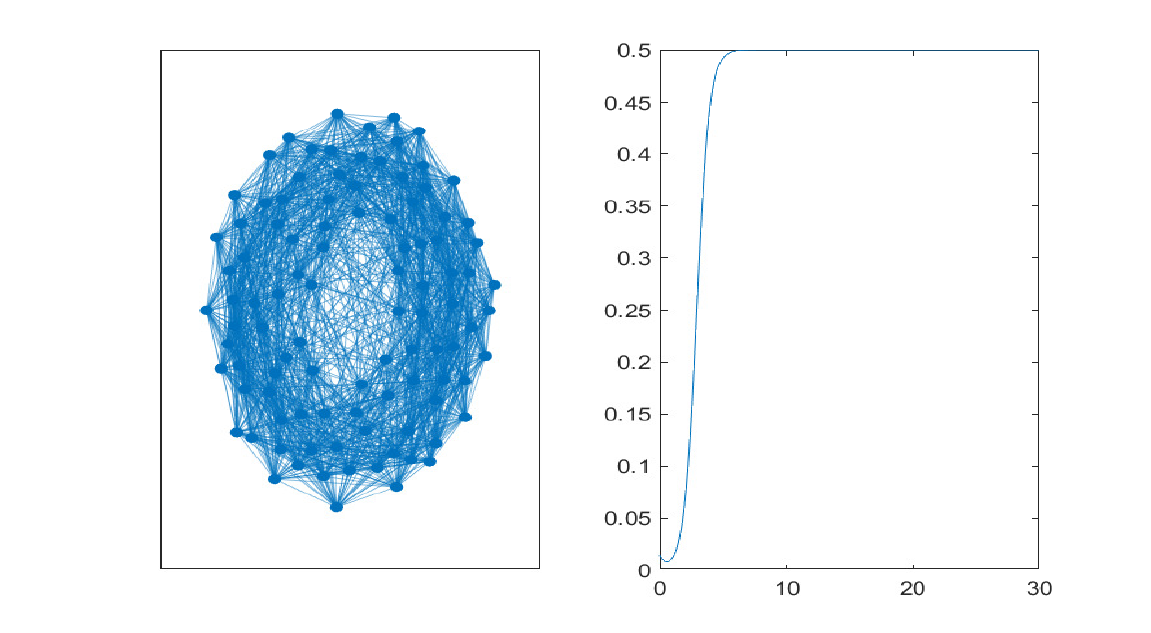
Figure 9. Small-world (Watts-Strogatz) network with 100 nodes and a rewiring probability of β = 0.1 ( left ). Time evolution of the mean value of non-performing loans on the graph ( right ).